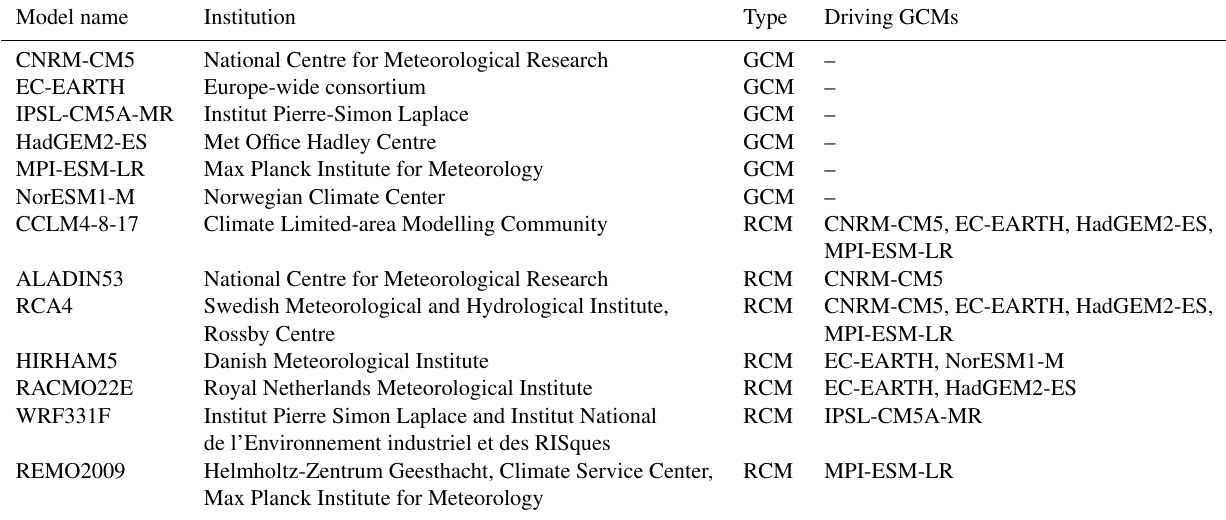
Table A1. List of GCMs and RCMs used in this